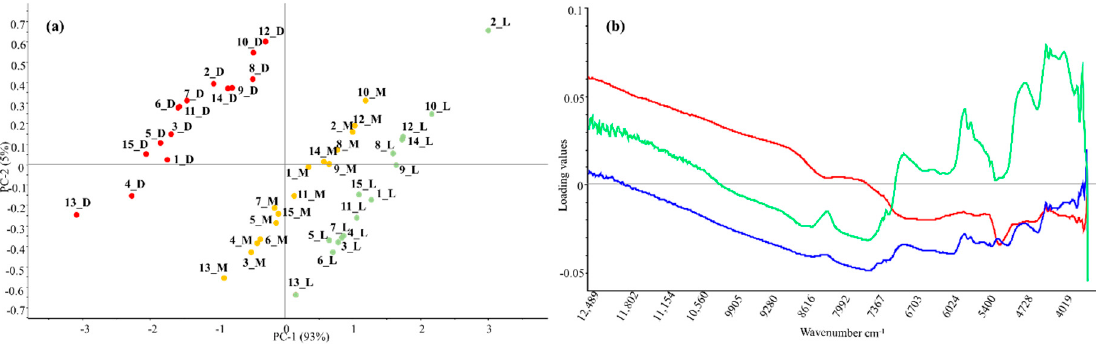
Figure 3. (a) Scores plot (PC1 vs PC2) of roasted coffee samples labelled with sample number and roasting level (L—light; M—medium; D—dark roasted). (b) Loading plots of the first three PC: PC1 ( ● ), PC2 ( ● ), PC3 ( ● ).